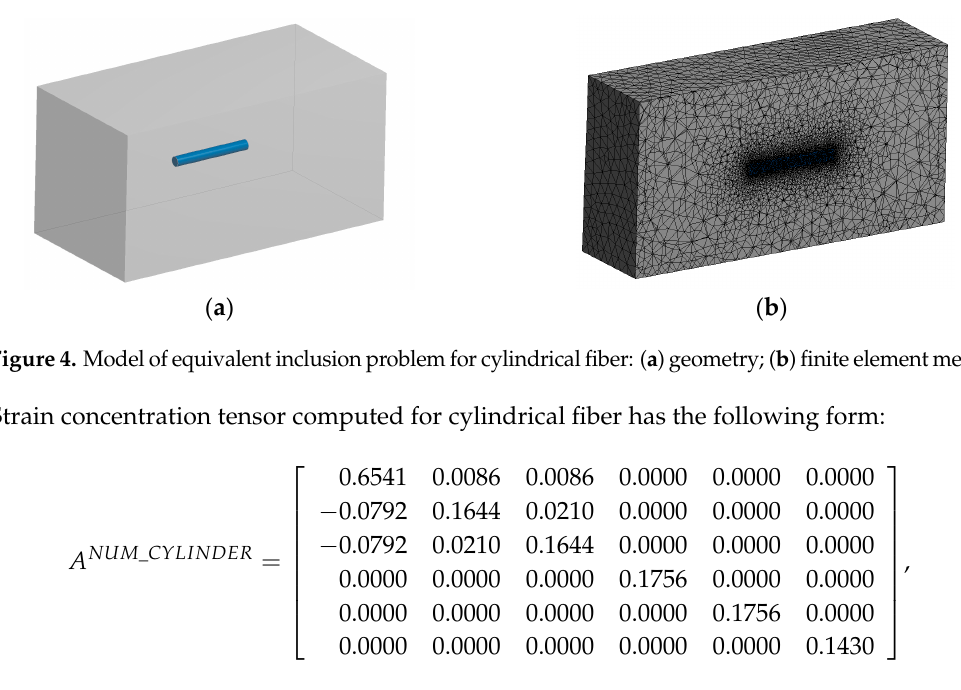
( c ) Figure 3. Representative volume elements representing composites reinforced with following volume fractions of cylindrical fibers: ( a ) 0.05; ( b ) 0.10; ( c ) 0.15.